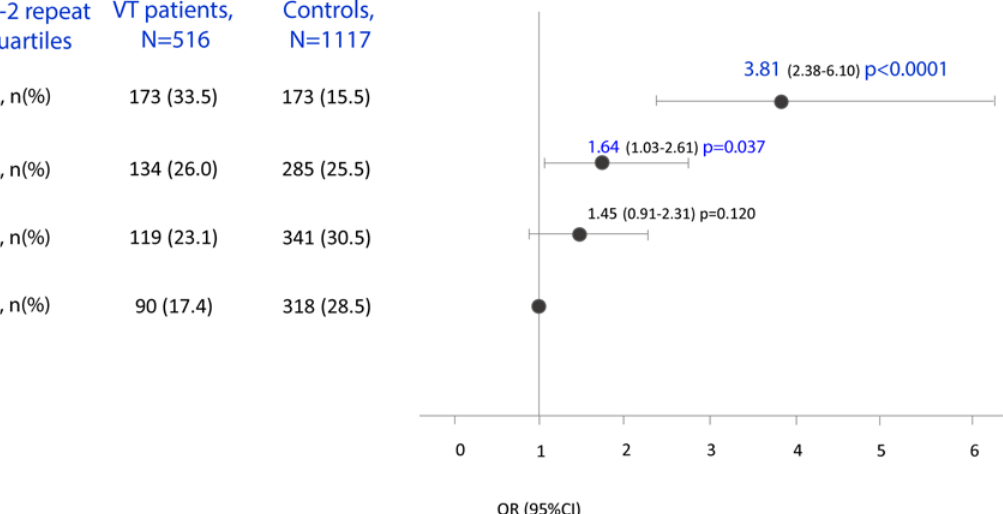
Fig 2. Association between KIV-2 repeat quartiles (Q1: (cid:1) 7 repeats; Q2: 8 – 12 repeats; Q3: 13 – 22 repeats; Q4: (cid:6) 23 repeats) and venous thromboembolism. Multivariate logistic regression analysis: adjusted for age, sex, hypertension, smoking habit, dyslipidemia, diabetes, BMI, hyperhomocysteinemia and oral contraceptives/HRT; Q4: reference